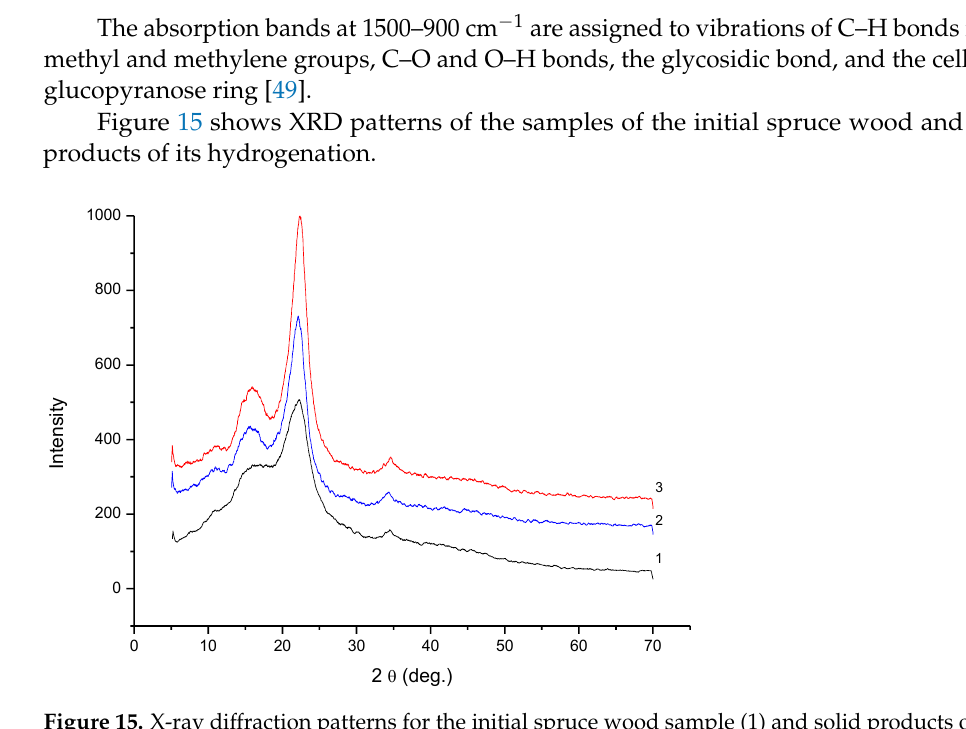
Figure 14. IR spectra for the initial spruce wood samples (1) and the solid products of wood RCF over the 3RS450 (2) and 3RS400 (3) catalysts.